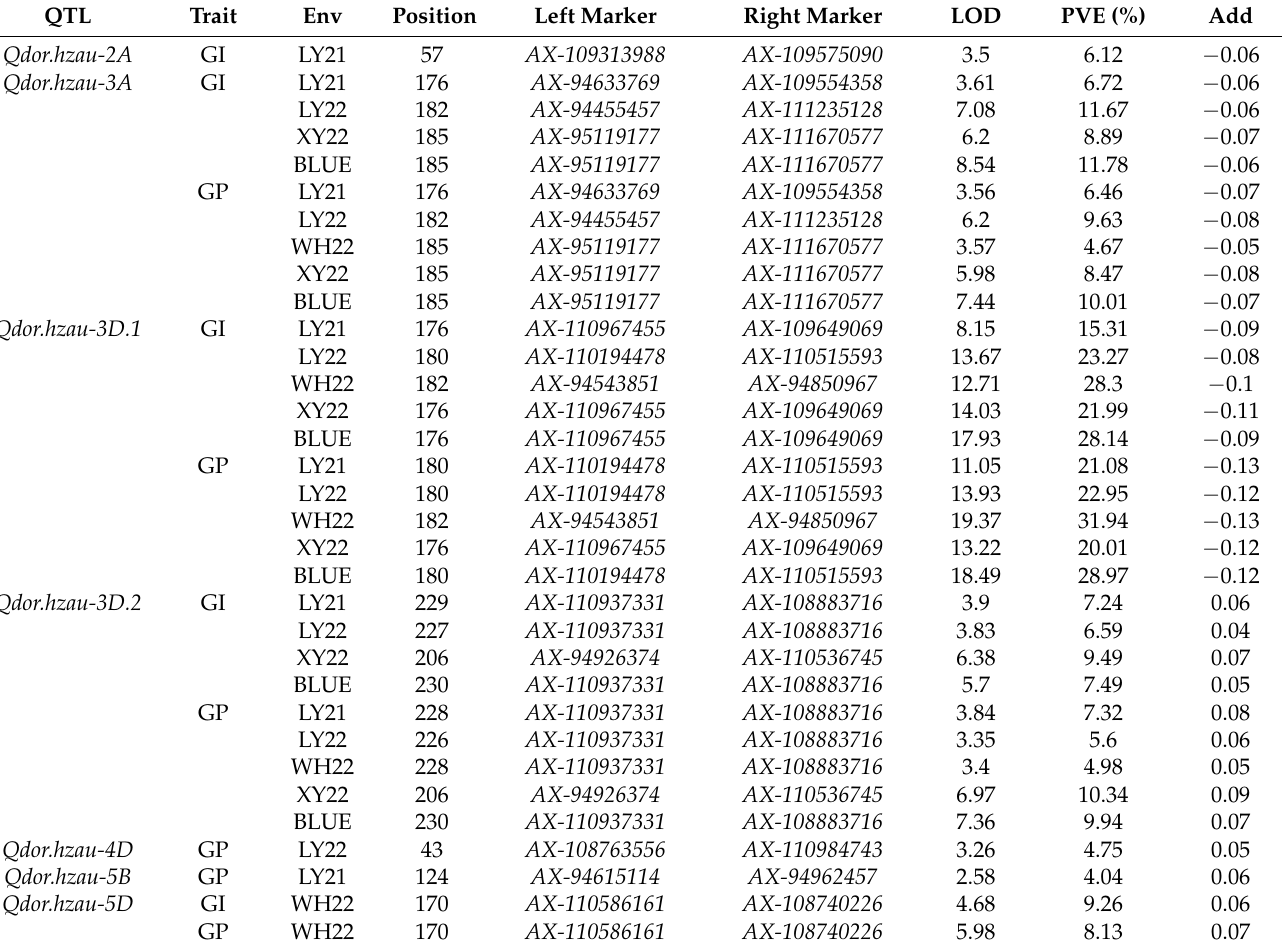
QTL, quantitative trait loci; Env, environment; Position, the genetic distance shown in cM; LOD, logarithm of odds; lines with YM16 allele and ZM895 allele in this DH population except for WH22 environ ‐ PVE, phenotypic variation explained by QTL; Add, additive effect with positive and negative values indicated an ment (Figure 1). increasing effect from ZM895 and YM16, respectively.